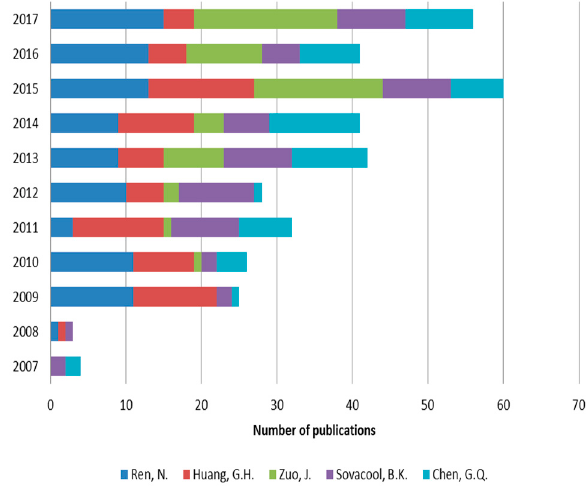
Figure 11. Author distribution regarding the number of publications during the 2007–2017 period. Table 4. Publications number of the most relevant authors between 2007 and 2017. Ren, N.